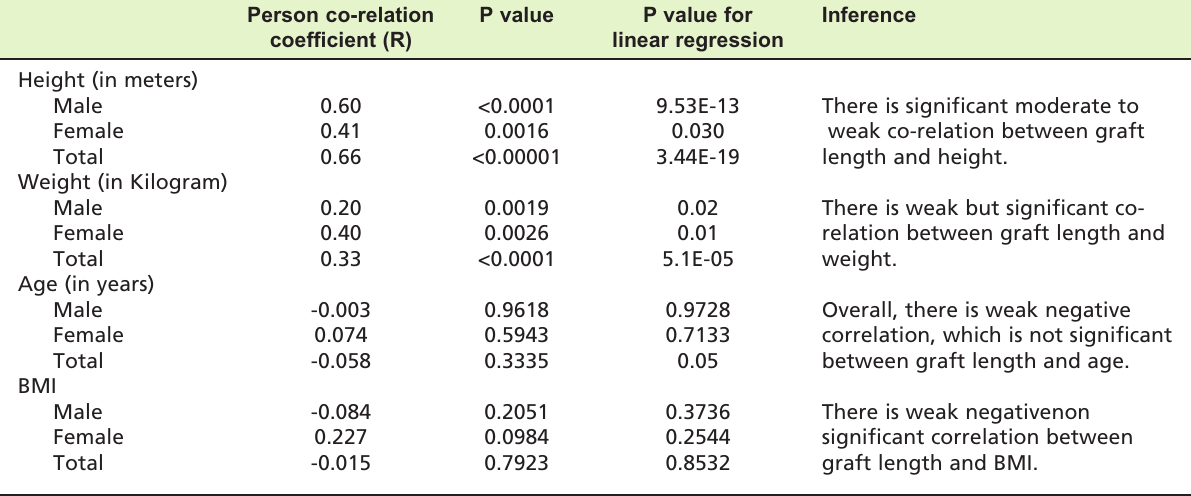
Correlation between graft length (GL) with parameters Table II: